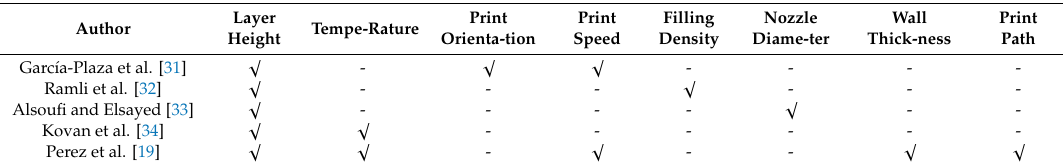
Table 1. Previous works that have studied the surface roughness of polylactic acid (PLA) printed parts using fused deposition modeling (FDM).